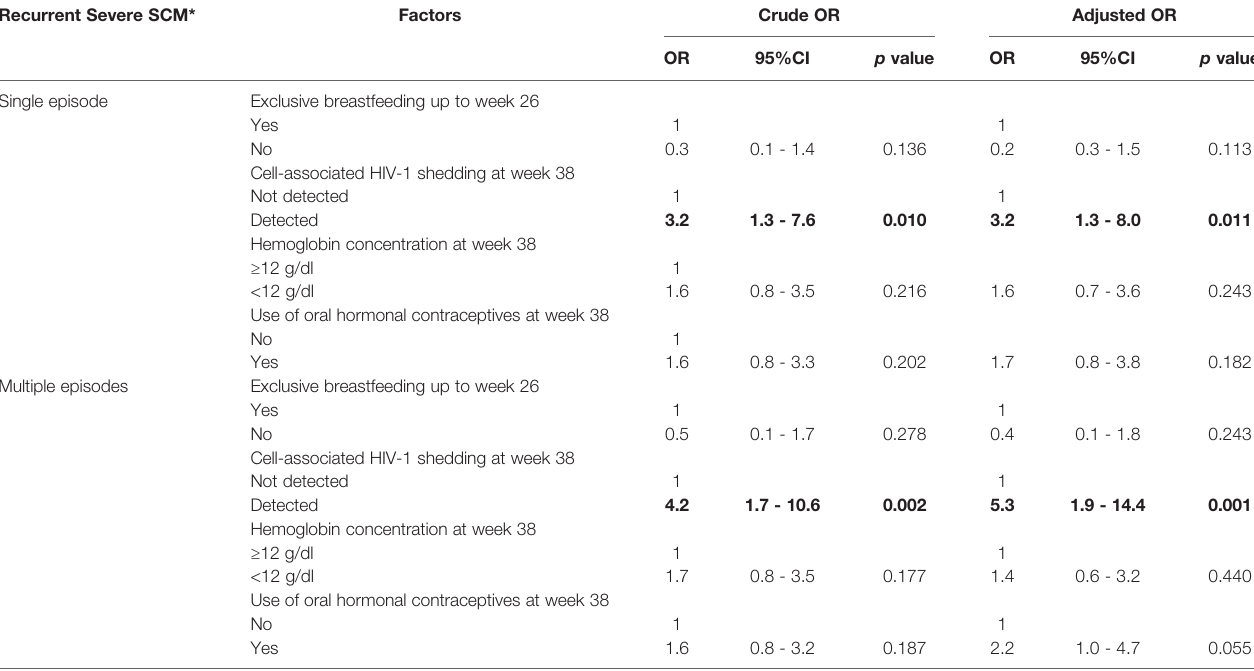
TABLE 5 | Effect of recurrent severe subclinical mastitis (SCM) on cell-associated viral (CAV) shedding in breast milk. Recurrent Severe